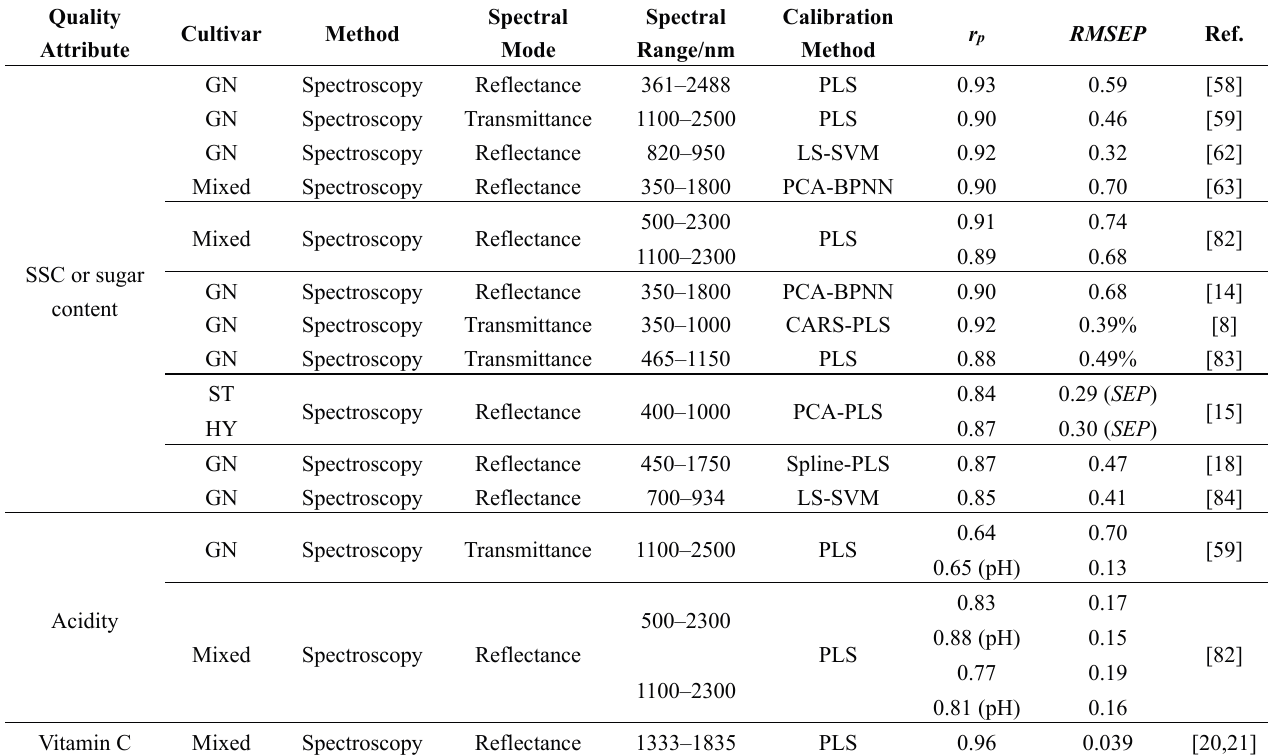
Table 3. Overview of applications for measuring quality attributes in